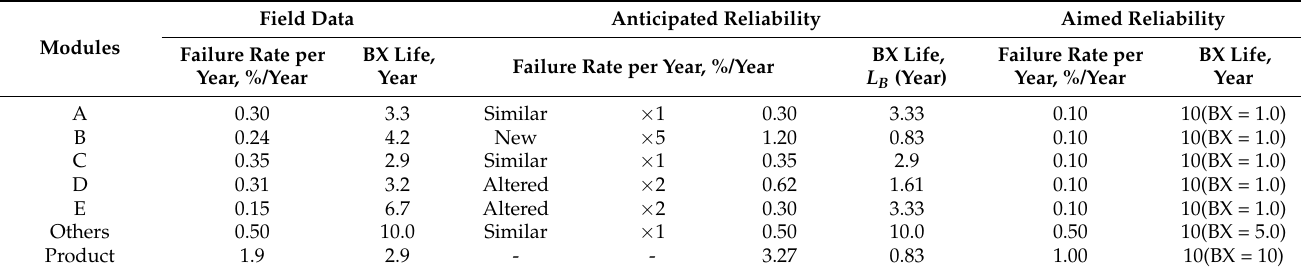
Table 1. Unabridged ALT strategy of mechanical modules in a domestic refrigerator.